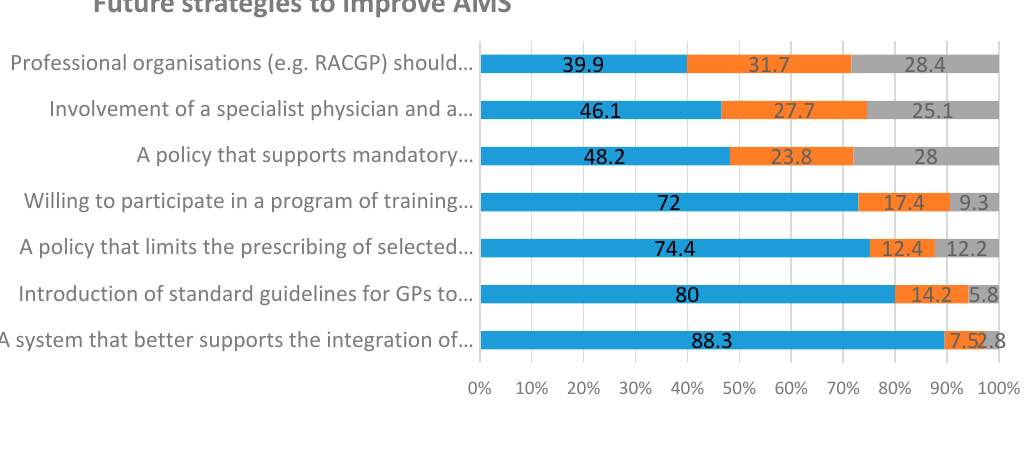
Table 2. Major barriers and facilitators to improving AMS by Australian GPs.